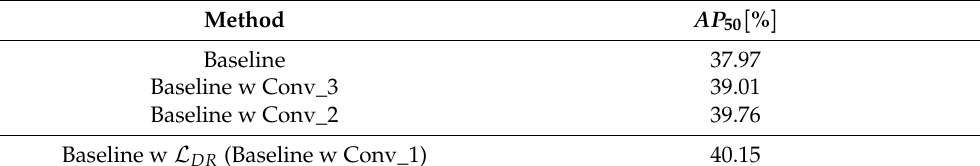
Table 3. Effectiveness of the Deraining